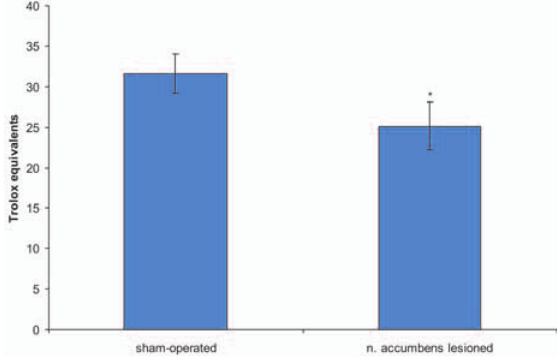
Figure 7. Effects of 6-OHDA-induced lesion of the NAcc on TAS levels from the temporal lobe. The values are mean ± SEM (n=6 animals per group). *p=0.04 vs. sham- operated